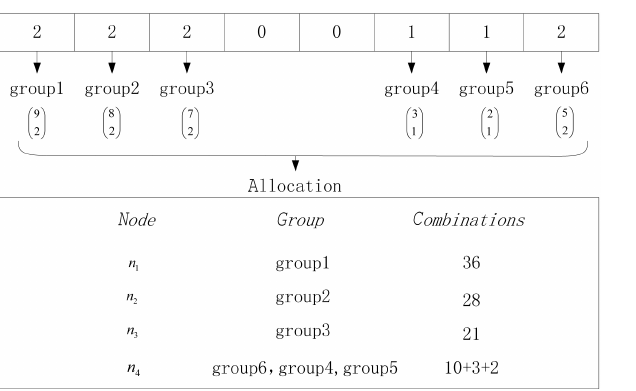
Fig. 4 The allocation process of